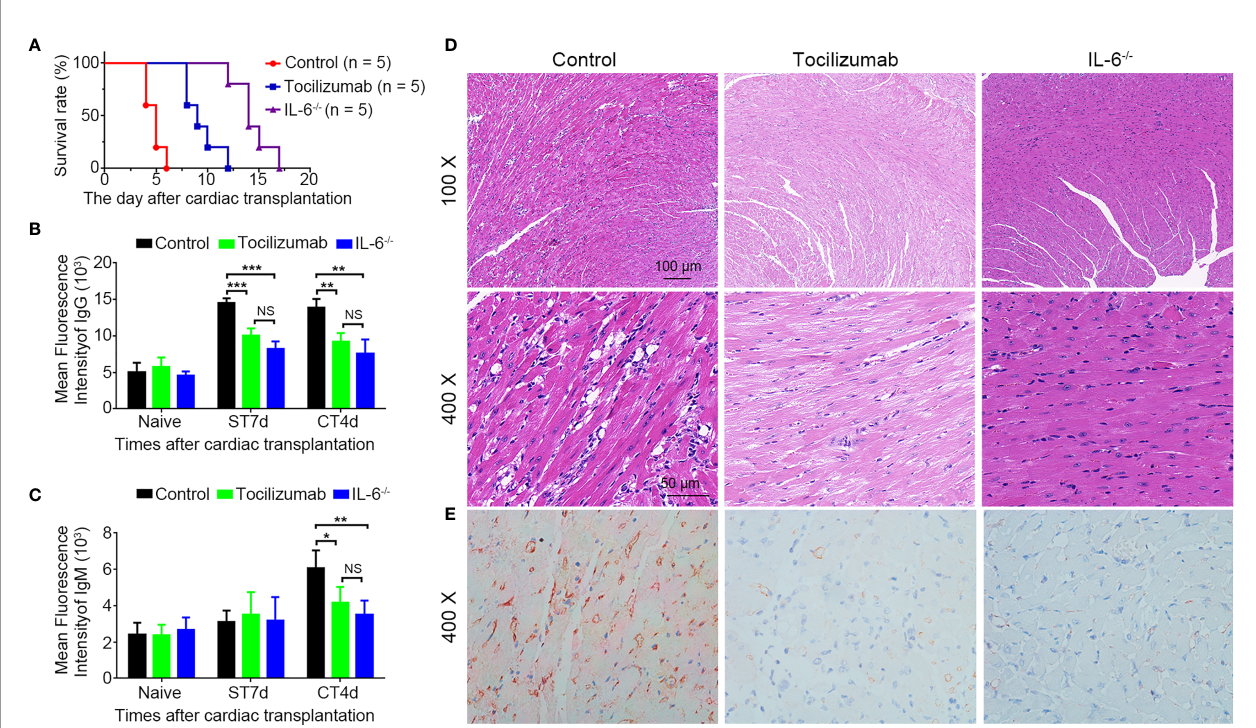
FIGURE 3 | Blockade of IL-6/IL-6R signaling attenuates acute antibody-mediated rejection. (A) Survival rate in the control, tocilizumab, and IL-6 -/- groups (n = 5/ group). (B, C) Changes in donor-speci fi c antibody IgG and IgM before and after transplantation in each group (n = 4/group). (D, E) Representative hematoxylin and eosin staining and C4d immunohistochemistry staining of cardiac allografts obtained 4 d post-operation in each group (n = 4/group). *P<0.05; **P<0.01; ***P<0.001; ST, skin transplantation; CT, cardiac transplantation. NS, no signi fi